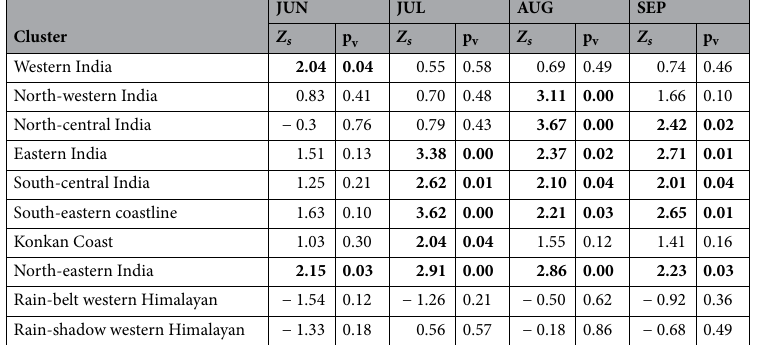
(Fig. 4g) is attributable to both the changing pattern of precipitation and temperature. For the Rain-belt Western Himalayan (see Fig. 1), CDHE (CWCE) frequency has decreased (increased) during June (Fig. 4a,e), which is deviating from the rest of the homogenous regions. The changes in compound extremes can be attributed to changing precipitation patterns (increase in Fig. 3a) and temperature (decrease in Fig. 3e). Sharma and Mujum- dar reported an increasing trend in droughts’ co-occurrence with longer heatwaves for western India, Central India and Peninsular India 27 . Further, Mishra et al., reported seven CDHE between 1951 and 2018, considering All-India monsoon precipitation and temperature 8 . Out of these seven CDHE, three have occurred in the past decade, indicating an increase in frequency to 3 events per decade. Our results on the change in frequency per decade agree with the previous study. Unlike the prior study, detailed regional information on the frequency and spatial extent changes are discussed in the following section.